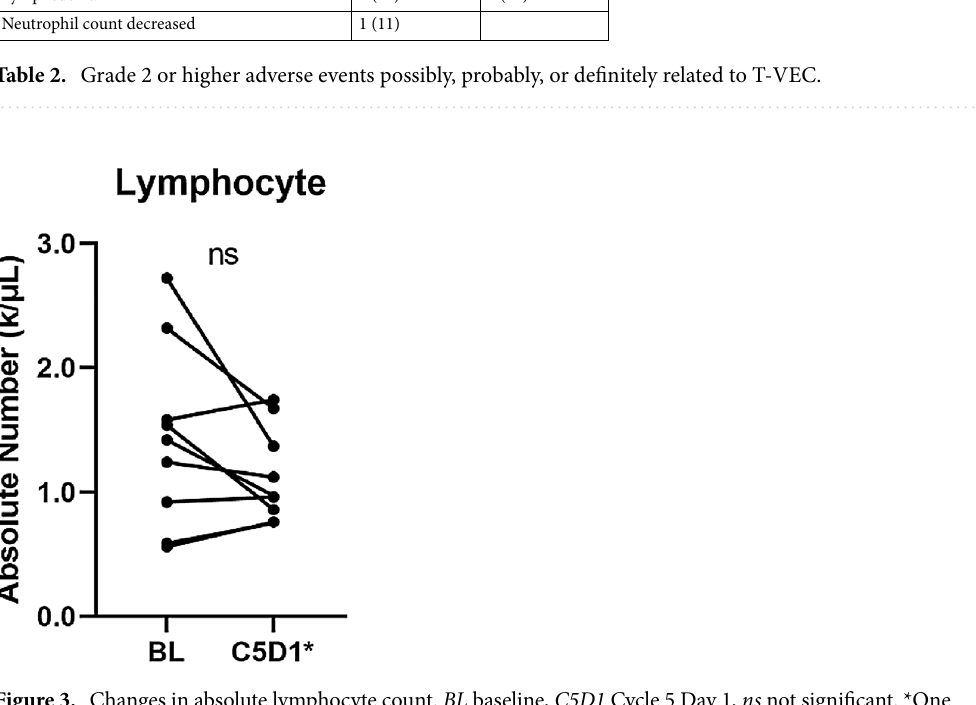
Figure 3. Changes in absolute lymphocyte count. BL baseline, C5D1 Cycle 5 Day 1, ns not significant. *One patient’s sample was collected before Cycle